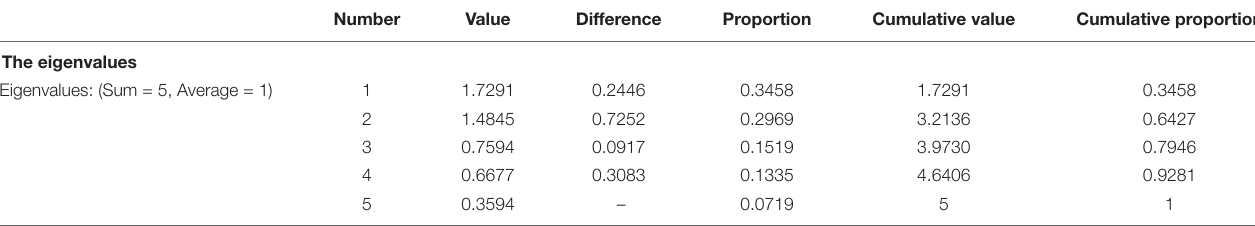
TABLE 7 | Principle component analysis (PCA) of the variables (China). Number Value Difference Proportion Cumulative value Cumulative proportion